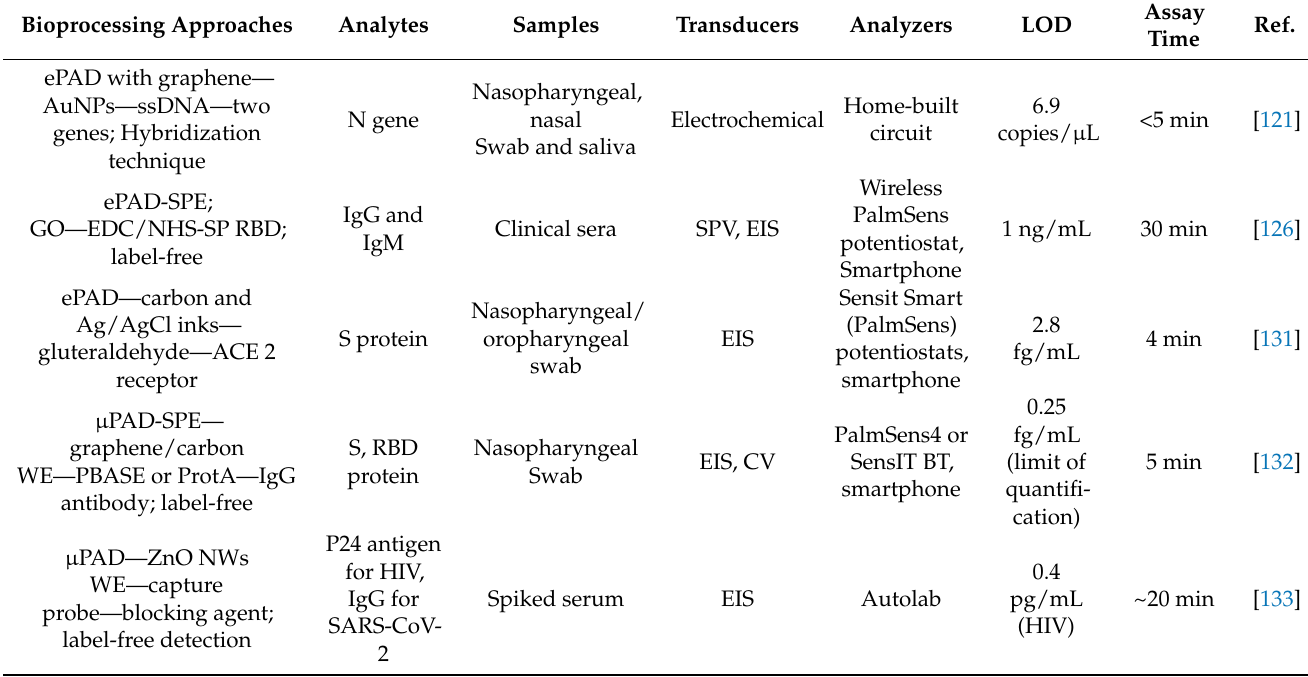
Table 2. Paper-based potential electrochemical biosensors for COVID-19 diagnosis. Bioprocessing